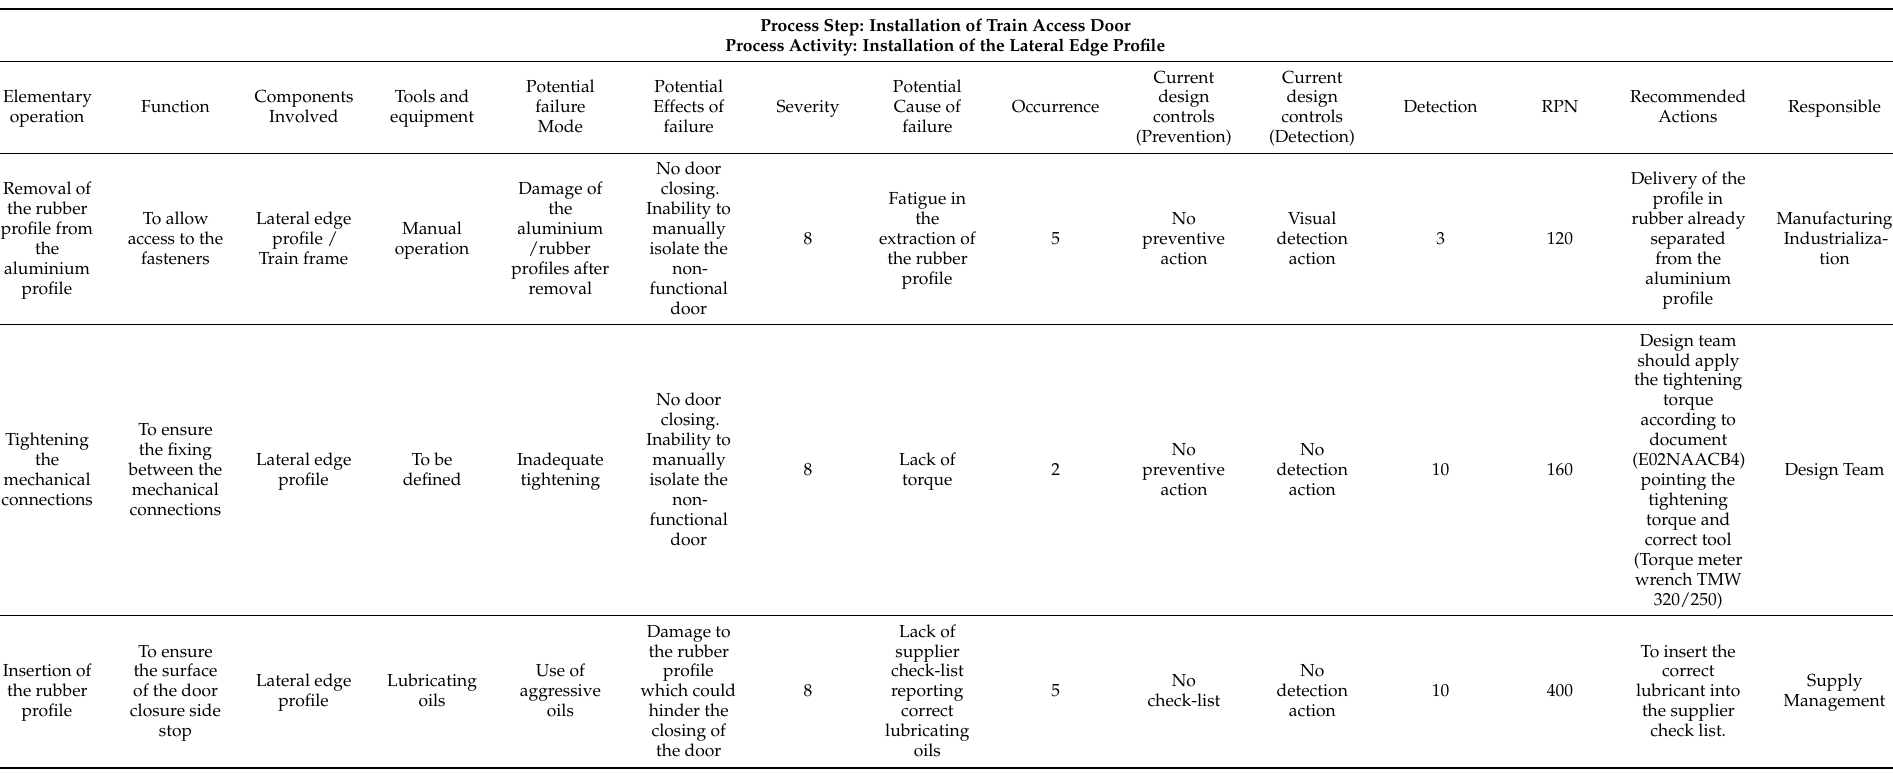
Table 7. An example of a scheme to present process failure mode and effect analysis (PFMEA)